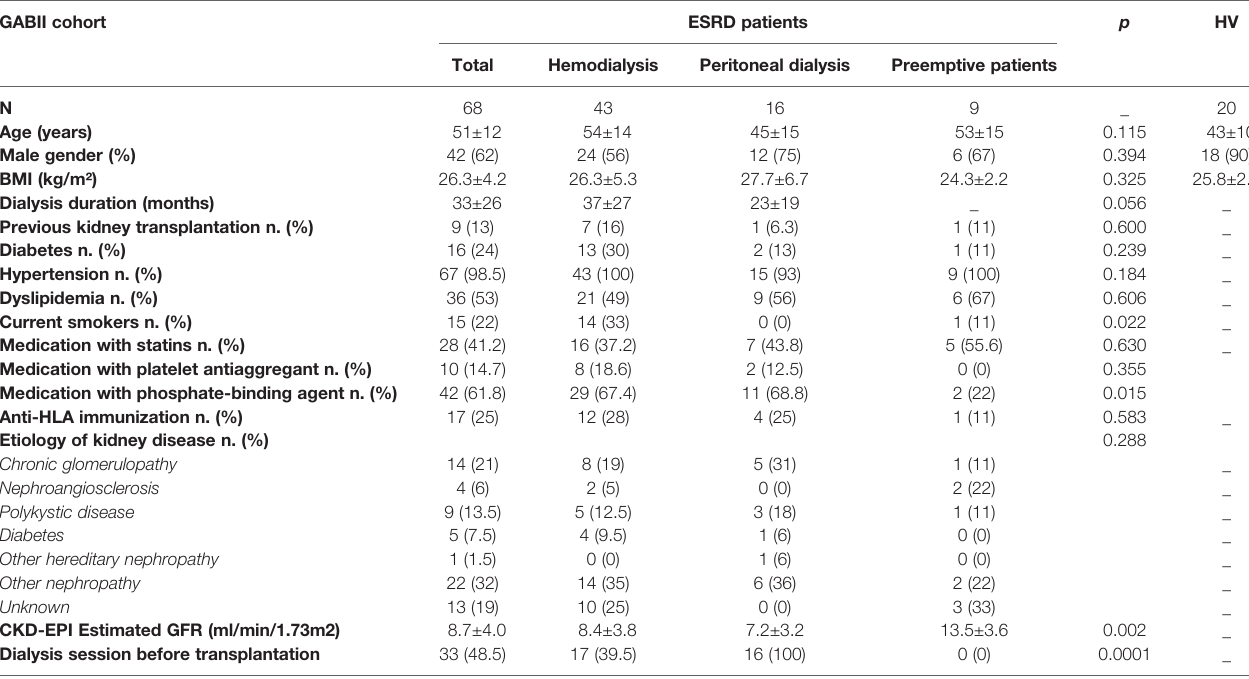
TABLE 1 | Characteristics of end-stage renal disease (ESRD) patients from GABII cohort and healthy volunteers (HV) included in this study. GABII cohort ESRD